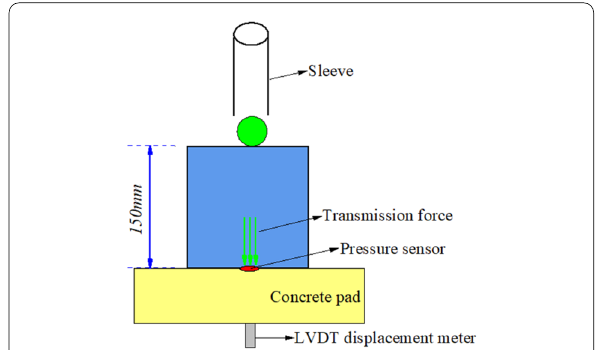
Fig. 19 The improved steel ball free fall impact test